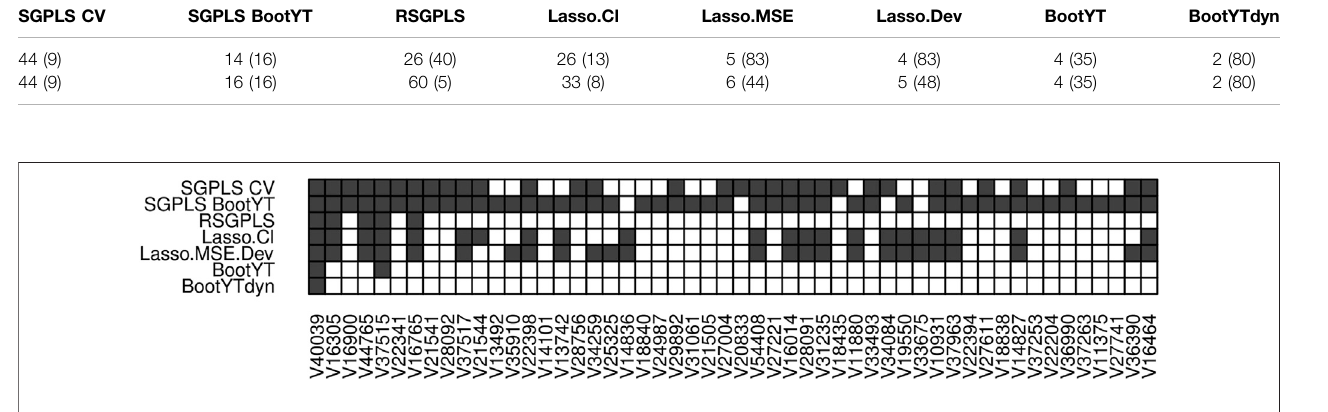
FIGURE 5 | Summary of selected supports.